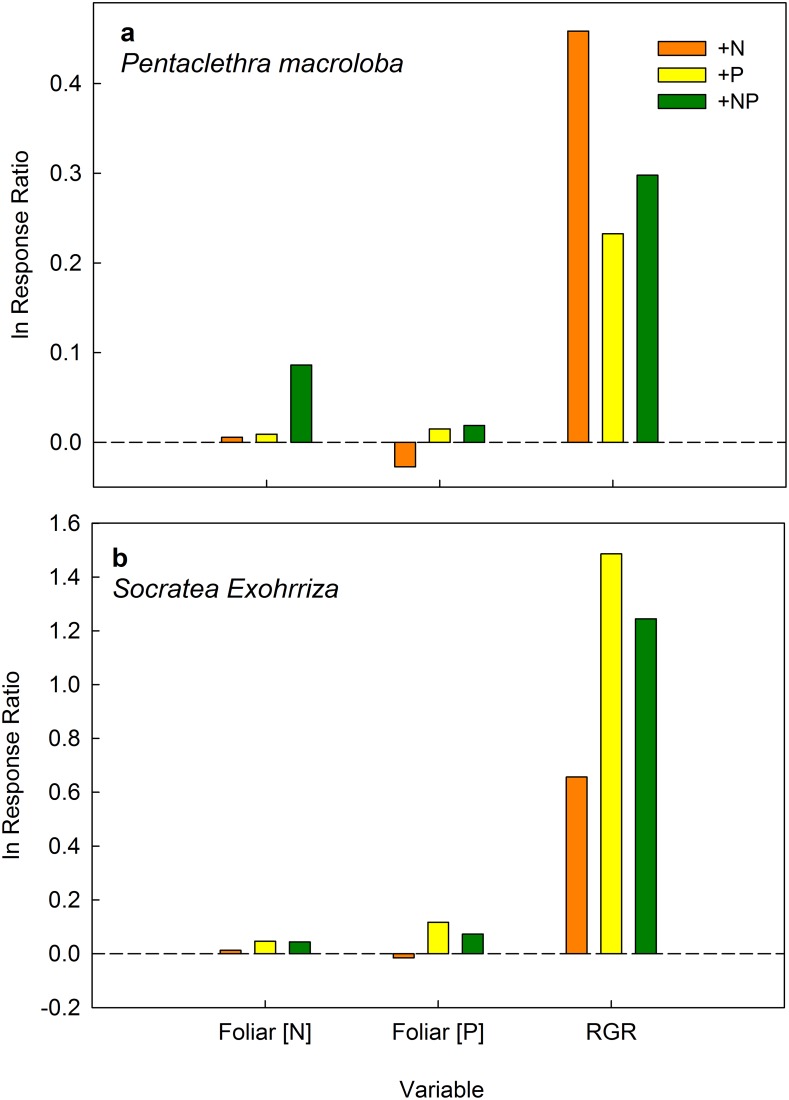
Changes in foliar nutrient concentrations and relative growth rate (RGR) for the fertilization treatments relative to the unfertilized controls for (A) Pentaclethra macroloba and (B) Socratea exorrhiza.Notice Y axis difference between panels.